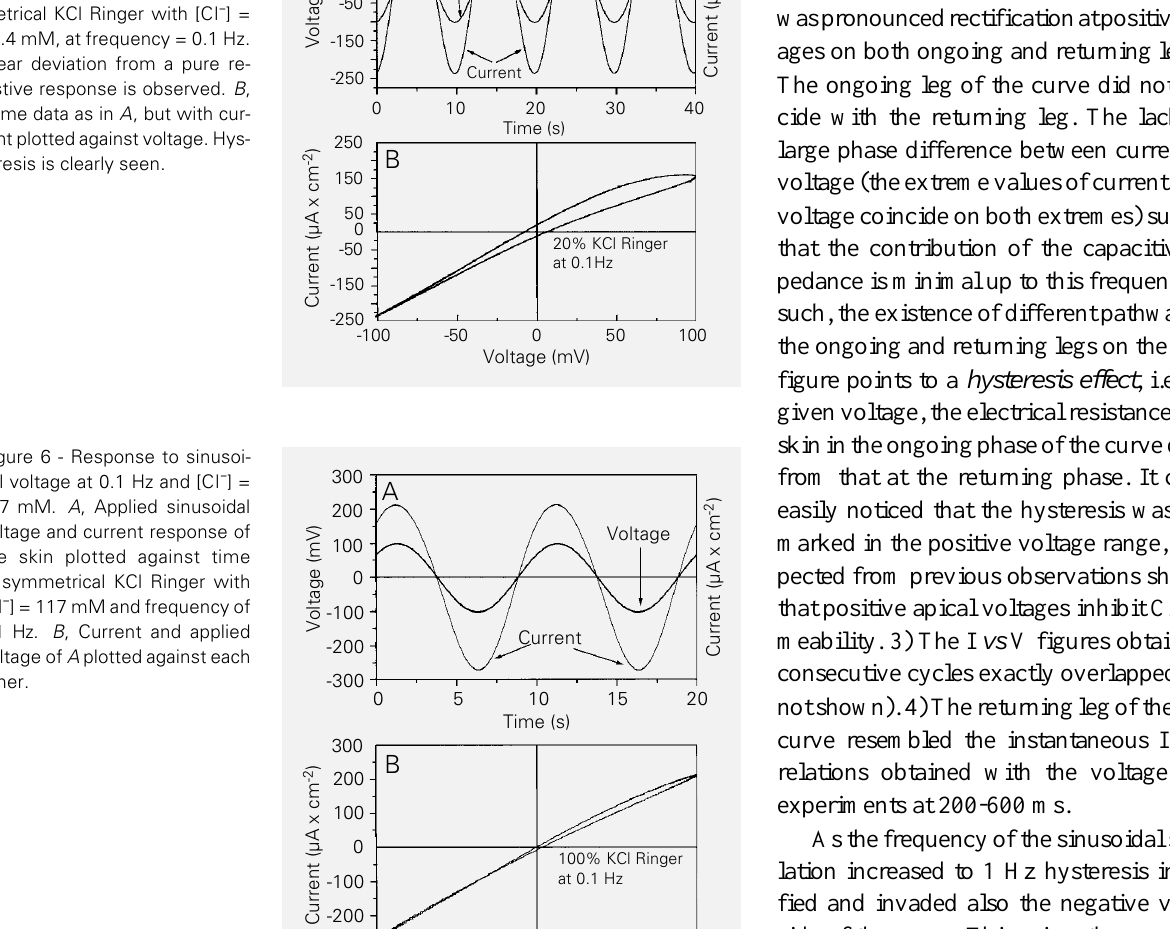
Figure 5 - Response to sinusoi- dal voltages at 0.1 Hz and [Cl - ] = 23.4 mM. A , Applied voltage and corresponding current response are plotted against time in sym- metrical KCl Ringer with [Cl - ] = 23.4 mM, at frequency = 0.1 Hz. Clear deviation from a pure re- sistive response is observed. B , Same data as in A , but with cur- rent plotted against voltage. Hys- teresis is clearly seen.